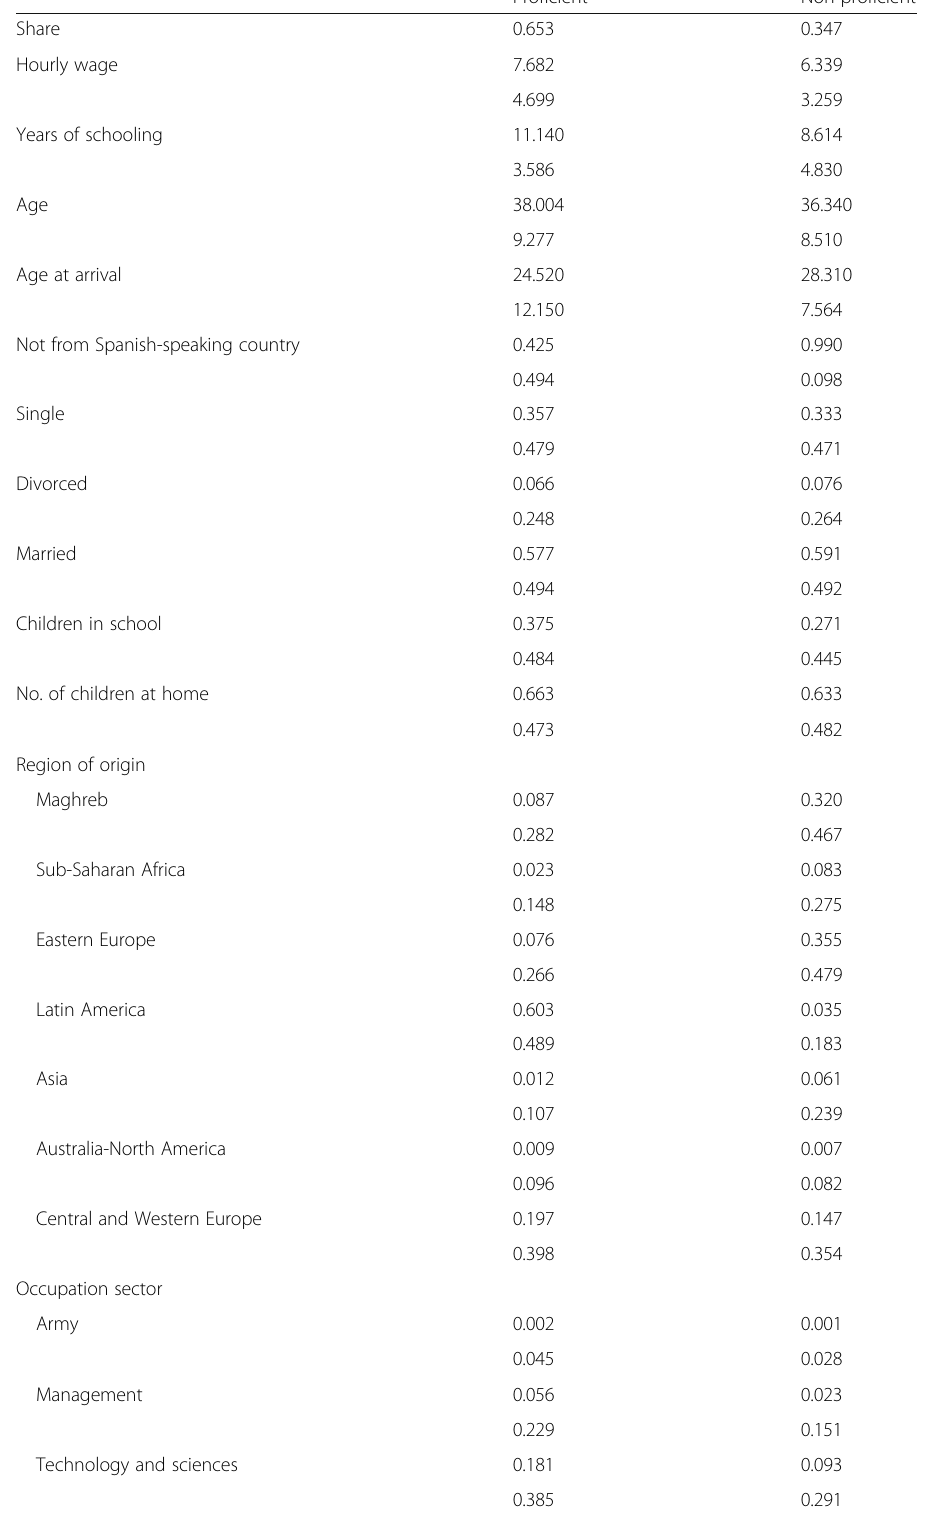
Table 1 Summary statistics by Spanish